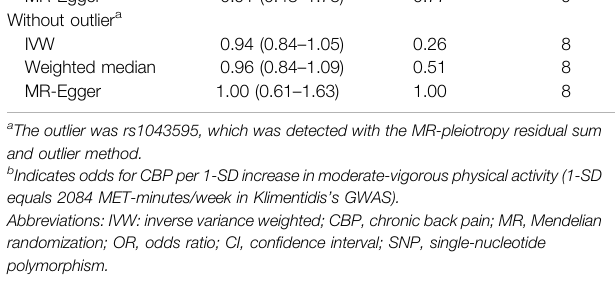
Abbreviations: IVW: inverse variance weighted; CBP, chronic back pain; MR, Mendelian randomization; OR, odds ratio; CI, con fi dence interval; SNP, single-nucleotide